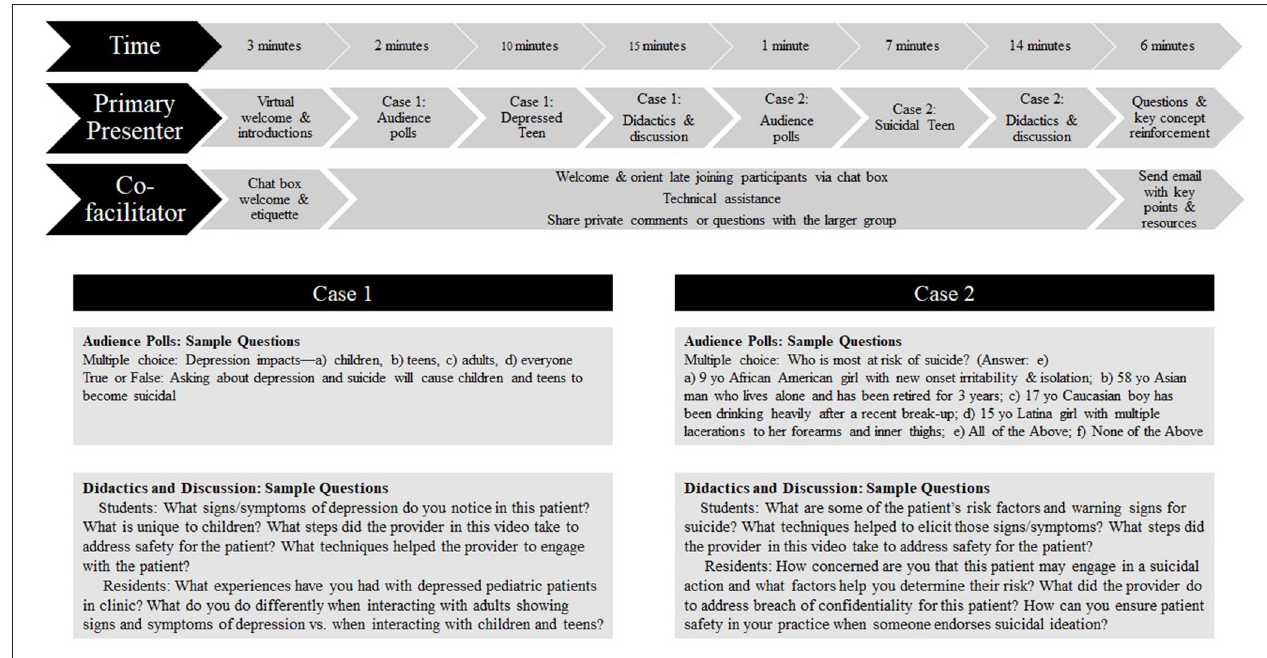
FIGURE 1 | INVEST Curriculum. Content above delivered by faculty boarded in Child & Adolescent Psychiatry. Supplemental work was performed by the co-facilitator, including chat box technical assistance, trainee engagement, and collecting trainee questions and